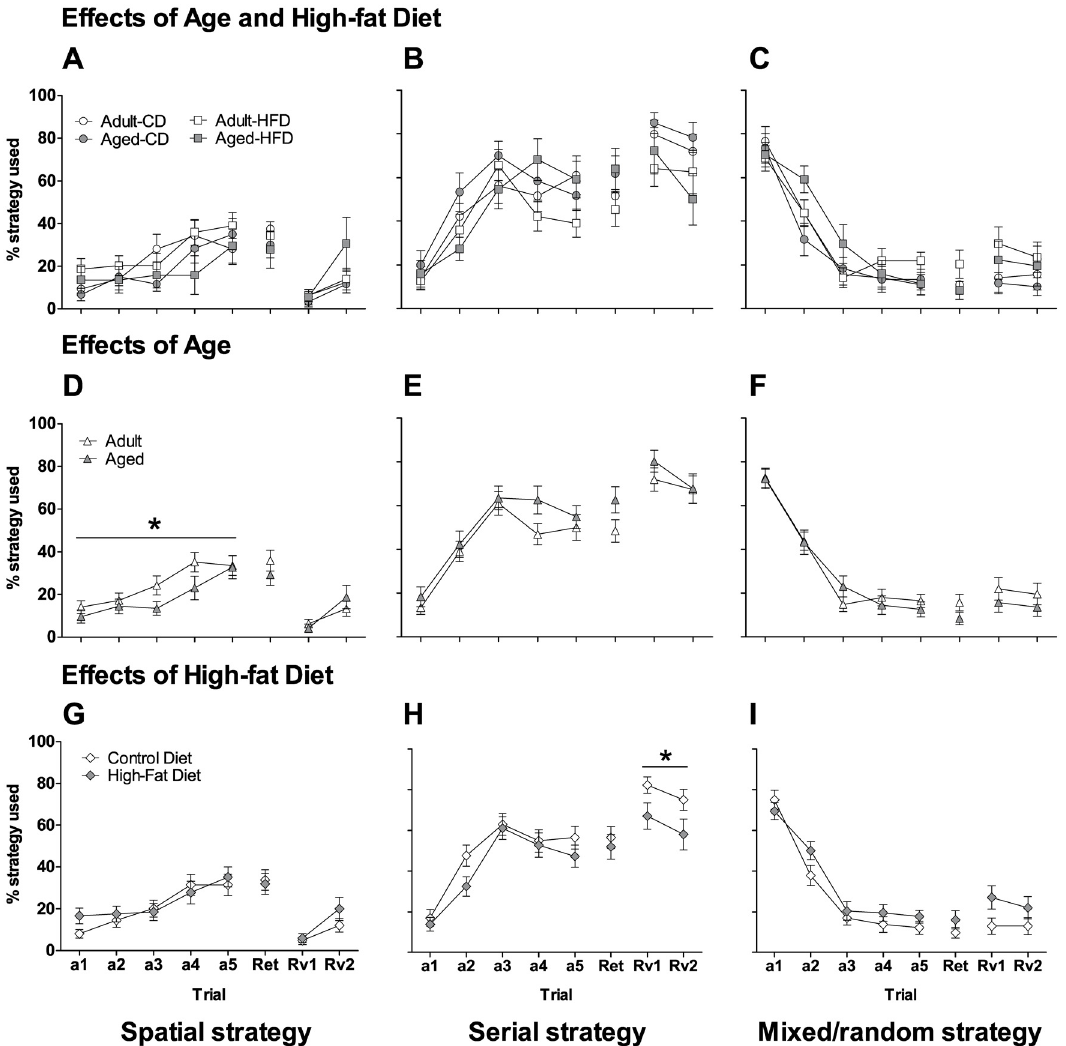
Fig 5. Effects of aging and exposure to high-fat diet on spatial strategy use in the Barnes maze. Spatial ( A,D,G ), serial ( B,E,H ) and mixed/random ( C, F,I ) strategy use by adult and aged mice on control diet (CD) and high-fat diet (HFD) on the Barnes maze acquisition days (a1-a5), retention day (Ret) and reversal learning days (Rv1-Rv2). In the top panels data for all groups are displayed, whereas in the middle and bottom panels data are collapsed for age and diet, respectively. Aged mice had significantly decreased spatial strategy use during the acquisition days compared with adult mice ( D ). Mice on the HFD used less serial strategy during the reversal learning days ( H ) and tended to use more mixed/random ( I ) compared with mice on CD. The data are expressed as mean ± SEM. * p < 0.05.